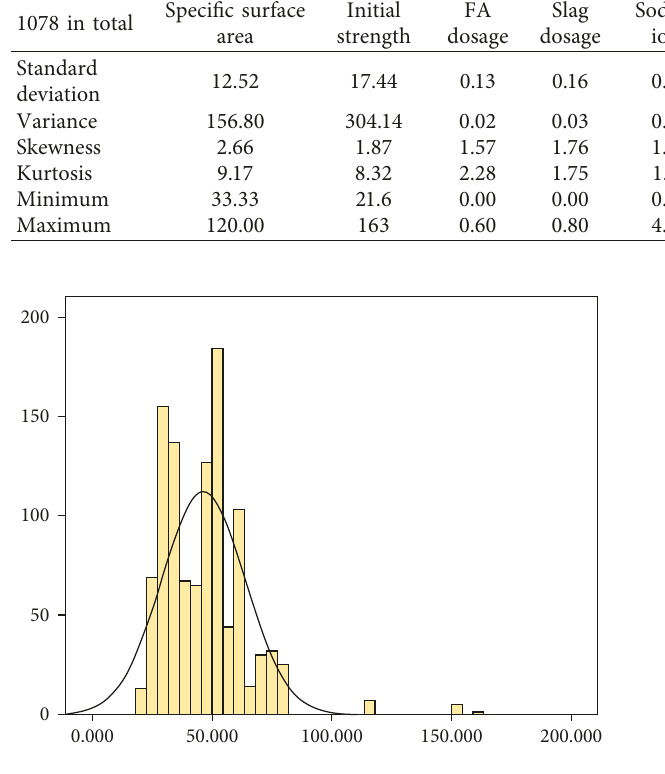
Figure 1: Distribution of initial strength.